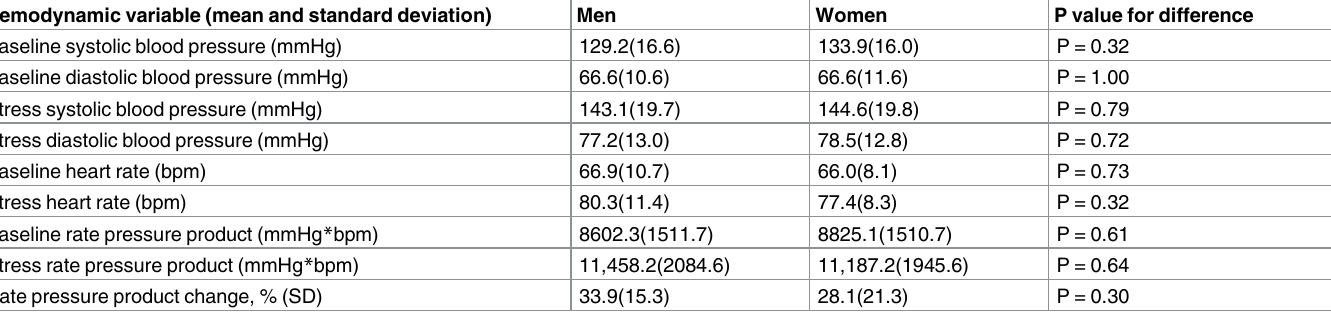
Table 2. Hemodynamic effect of isometric handgrip stress.